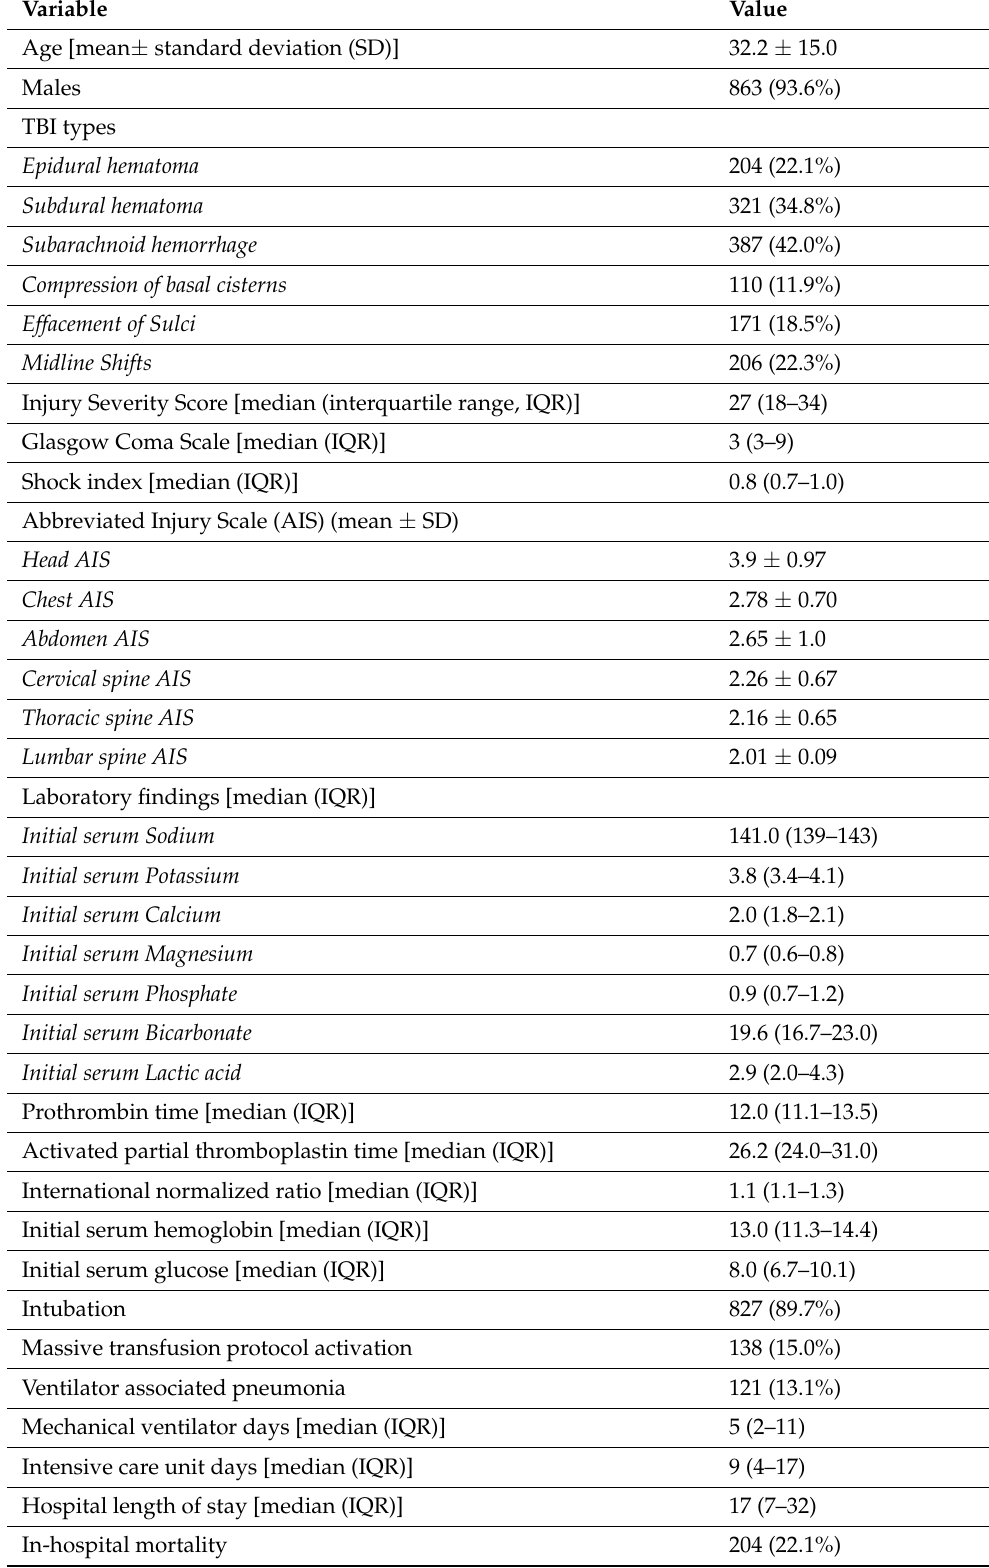
Table 1. Demographic and clinical variables of hospitalized traumatic brain injury patients (TBI) ( n =